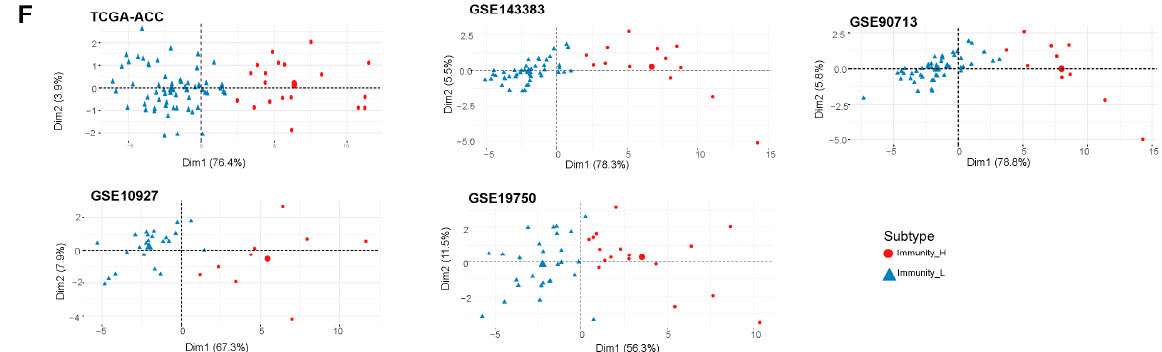
Figure 1. Hierarchical clustering of ACC tumors based on the enrichment of 23 immune signatures. ( A ) Clustering analyses uncovering two immune subtypes of ACC: Immunity-H and Immunity-L, which have high and low immune cell enrichment scores, respectively, consistently in five datasets.